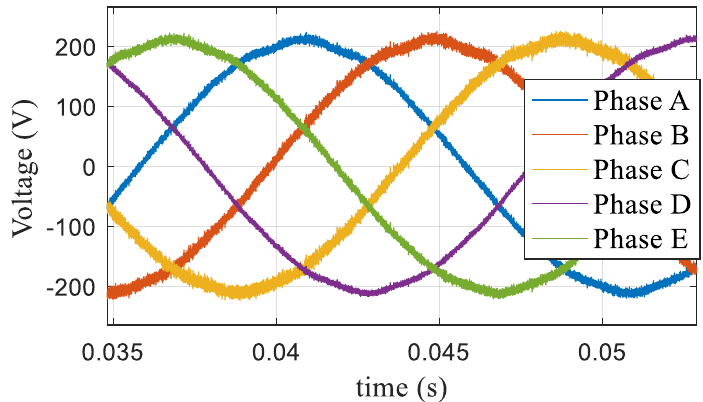
Figure 26. Voltage waveform based on the dynamic modulation algorithm at m = 1.0514.